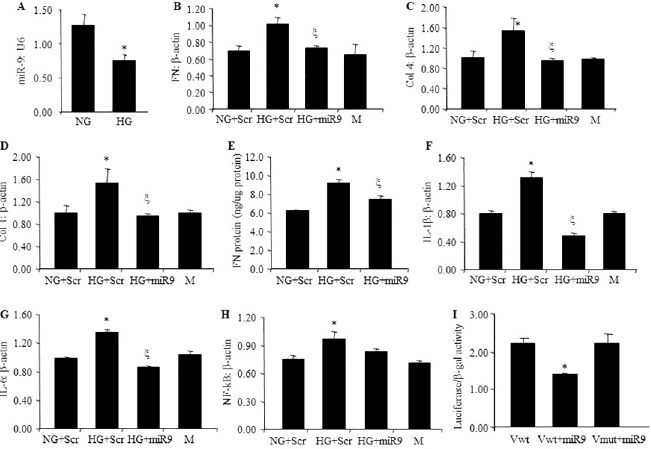
Fig 1. miR-9 regulates glucose-induced production of ECM in vitro in HCMEC. RT-qPCR analyses indicating HG- induced downregulation of (A) miR-9 transcript, (B, C, D) ECM transcripts (FN, Col4a1, Col1a1) and (E) FN protein expression in HCMECs. Similar glucose induced effects were also seen regarding proinflammatory markers (F), IL-1 β , (G) IL-6, and H) NF-kB1. Such glucose-induced increases of these ECM were prevented following (B-H) miR-9 mimic transfection Luciferase reporter assay demonstrated the interaction between miR-9 and FN(I). (mRNA expressed as a ratio to β -actin; � p < 0.05, compared to Scr HG; Scr = scrambled mimic; NG = 5 mM D-glucose; HG = 25 mM D- glucose; M = 25 mM mannitol; Vwt = wild pMIR vector; Vmut = mutant pMIR vector; n = 6).